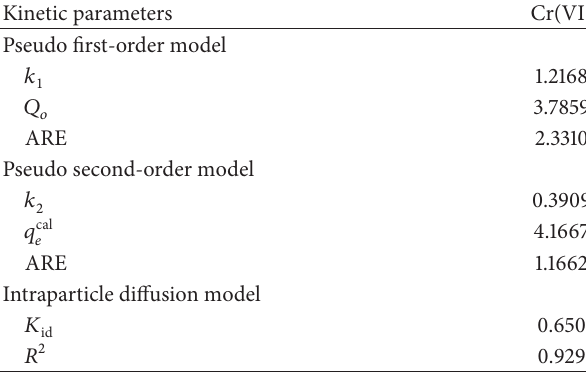
Table 3: Parameters of kinetic modelling for adsorption of